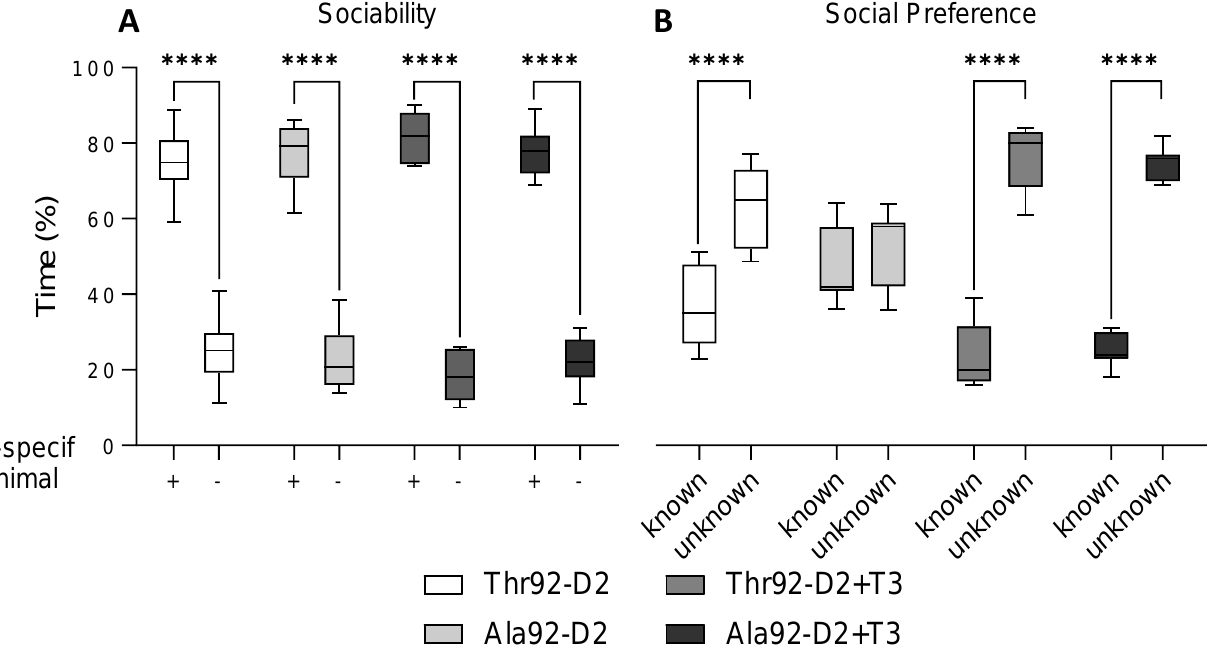
Figure 2. Cognitive tests in 3–4-month-old female mice. The social recognition tests are displayed as time (% of total time) to assess sociability ( A ) and social preference ( B ) for Thr92-Dio2 and Ala92-Dio2 mice and mice treated with T3 for ten days; in each plot, “+” represents a co-specific animal and “ − ” represents an empty cage, and k represents a familiar mouse and uk represents an unknown mouse; n = 6–7/group. **** p < 0.001 as calculated through the two-way ANOVA followed by the Bonferroni post-test. These experiments were repeated once with similar results; only one set of results is shown in the